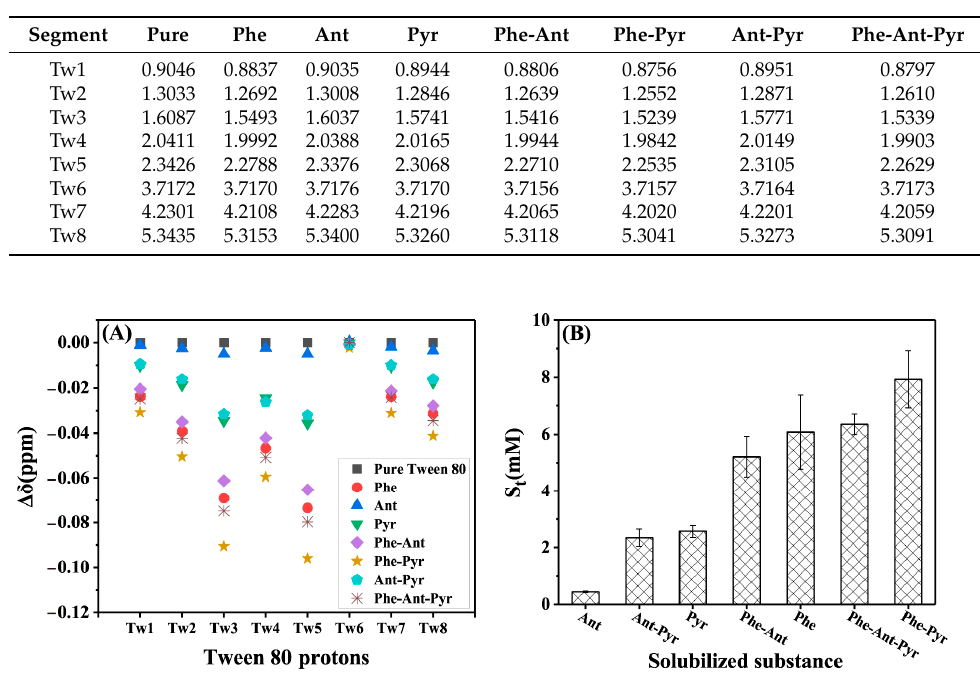
Figure 3. Chemical shift variations of Tween 80 protons ( A ) compared to those of pure Tween 80 and the total solubility ( B ) in different solubilization systems at the same Tween 80 concentration of 50 mM.